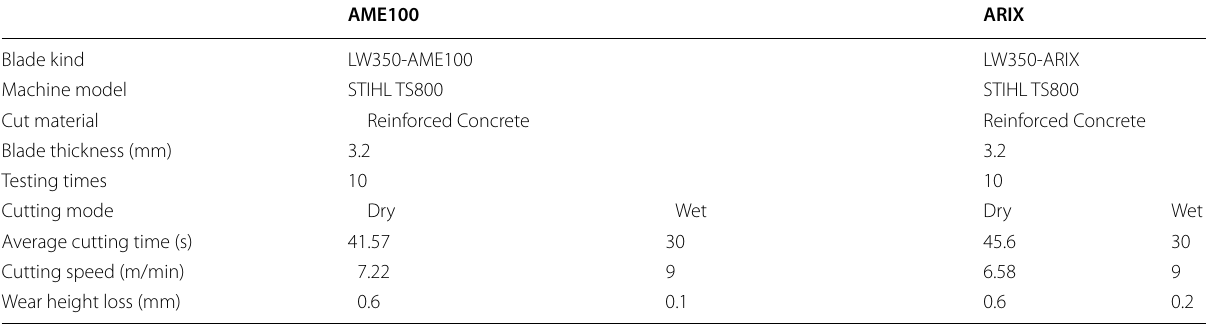
Table 4 Experiment involving cutting of reinforced concrete under different